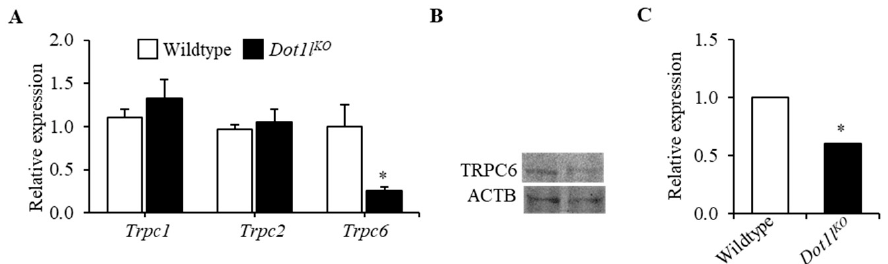
Figure 4. Expression of TRPC6 was markedly reduced in KIT-positive Dot1l KO hematopoietic progen- itors. ( A ) Among the three genes in the Trpc family (i.e., Trpc1 , Trpc2 , and Trp6 ), only Trpc6 levels were dramatically reduced in Dot1l KO compared to WT, while the levels of the other members remained relatively unchanged. TRPC6 protein levels in KIT-positive progenitor cells from Dot1l KO yolk sacs were also significantly reduced ( B , C ). Data are expressed as the mean ± SE; n > 6; * p <